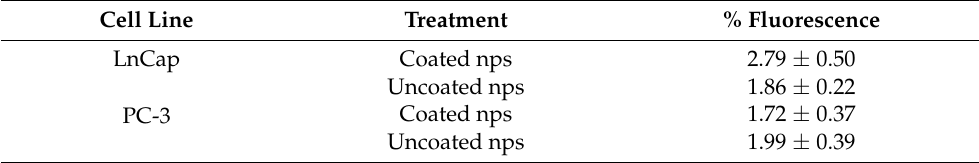
Table 5. Fluorescent intensities of LnCap and PC-3 cells treated with coated and uncoated